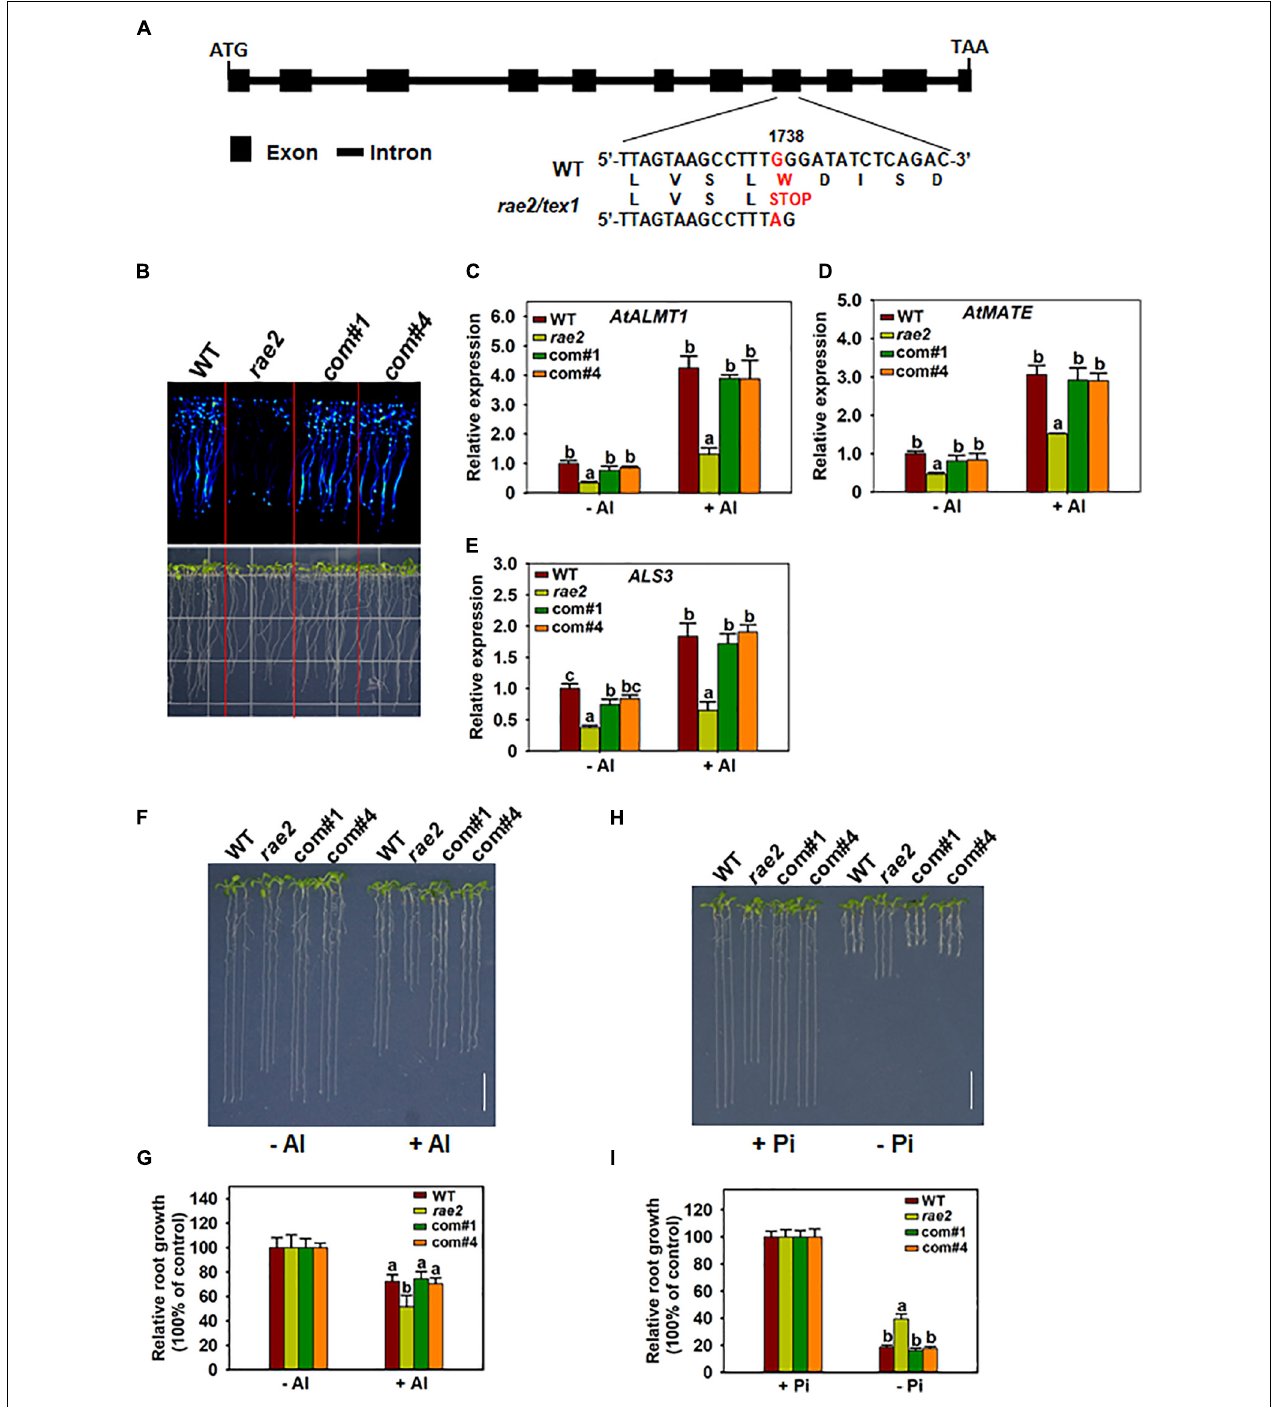
FIGURE 3 | Complementation test of rae2 mutant. (A) Gene structure and mutation sites of RAE2 . Boxes and horizontal lines between the boxes indicate the coding regions and introns, respectively. A single-nucleotide substitution from G to A was occurred at +1738 from the start codon in rae2 , which causes an amino acid change from tryptophan to stop codon. (B–E) The decreased LUC signal (B) and expression of STOP-regulated genes in rae2 , including AtALMT1 (C) , AtMATE (D) , and ALS3 (E) , were rescued in two complementation lines. Roots of 7-day-old seedlings were exposed to 0 (–Al) or 30 µ M Al (+Al) for 12 h for the expression analysis. Values are means ± SD ( n = 3). (F,G) Complementation of Al resistance phenotype. Representative images (F) and relative root growth (G) of WT, rae2 , and complementation lines at different Al concentrations. Values are means ± SD ( n = 18–23) (H,I) Complementation of low Pi response phenotype. Representative images (H) and relative root growth (I) of WT, rae2 , and complementation lines at different Pi concentrations. Values are means ± SD ( n = 19–22). Means with different letters are significantly different ( P < 0.05, ANOVA followed by Tukey’s test).